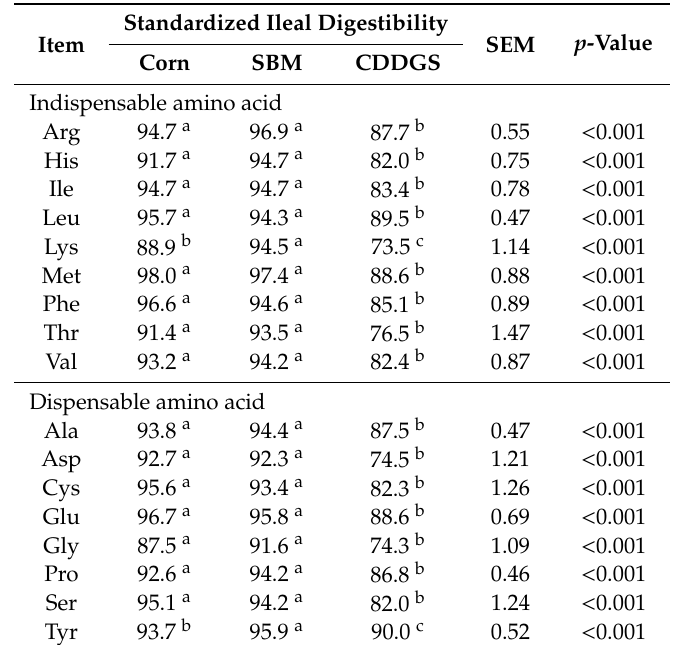
Table 6. Standardized ileal amino acid digestibility (%) of broilers fed corn-, SBM-, and CDDGS- based